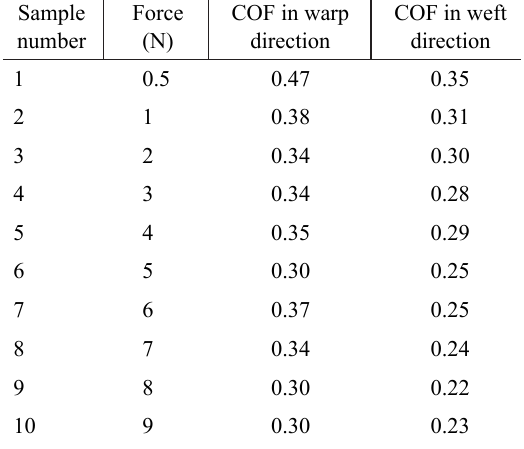
Table 3. COF results of TiAlN coated steel balls for force